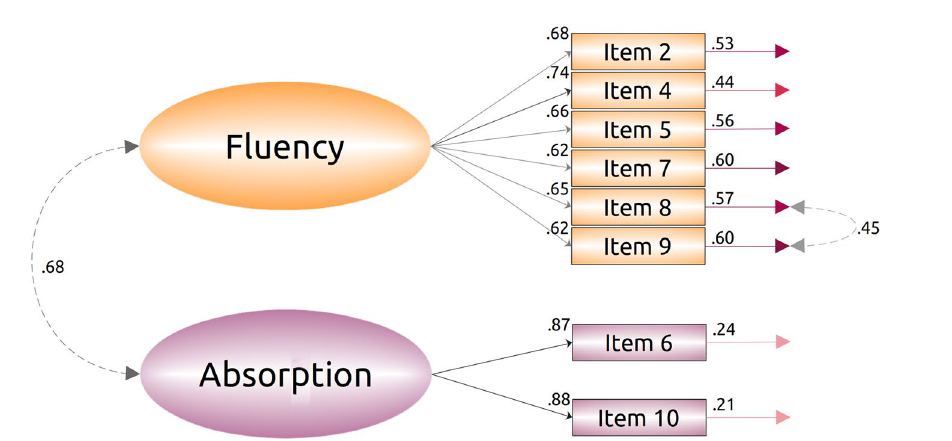
Figure 3. Final Confirmatory Factor Analysis for the 8-item Finnish FSS. This model has a good fit with the 2 data: χ (18) = 31.07, CFI = 0.97, TLI = 0.96, RMSEA = 0.06, 90% CI [0.027, 0.090], SRMR =